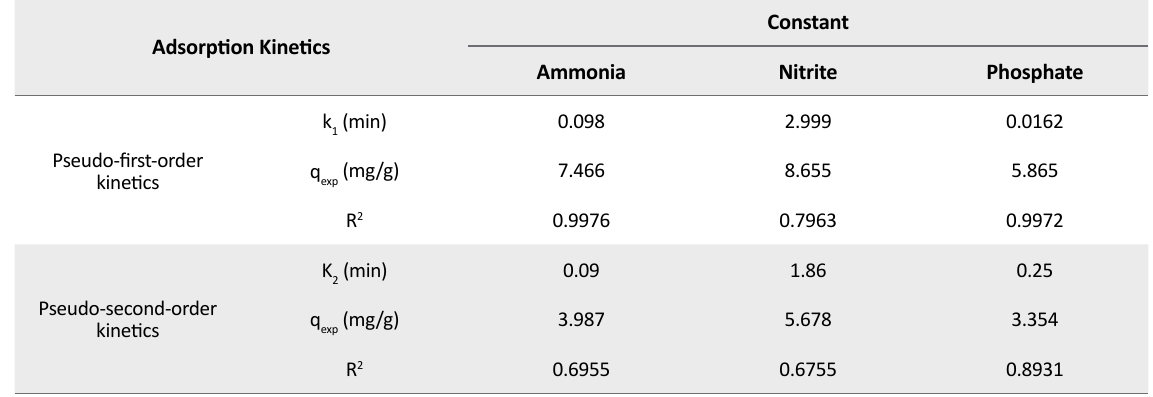
Table 5. The constant kinetic coefficients